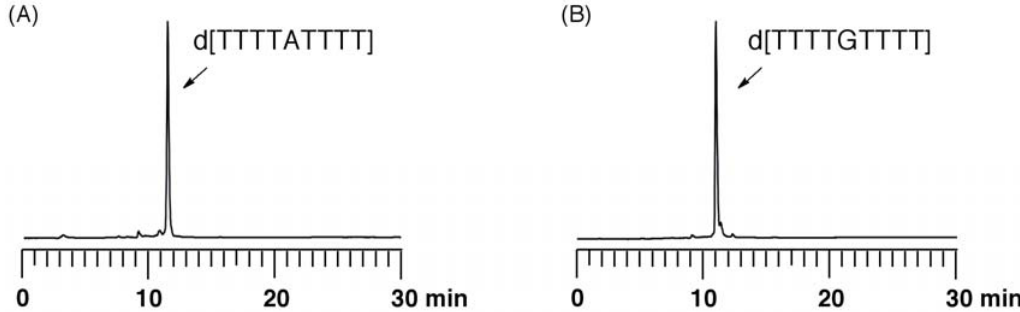
Figure 5. Analysis of depurination using ODNs containing (A) A phth or (B) G i Bu·dibe by reverse-phase HPLC.